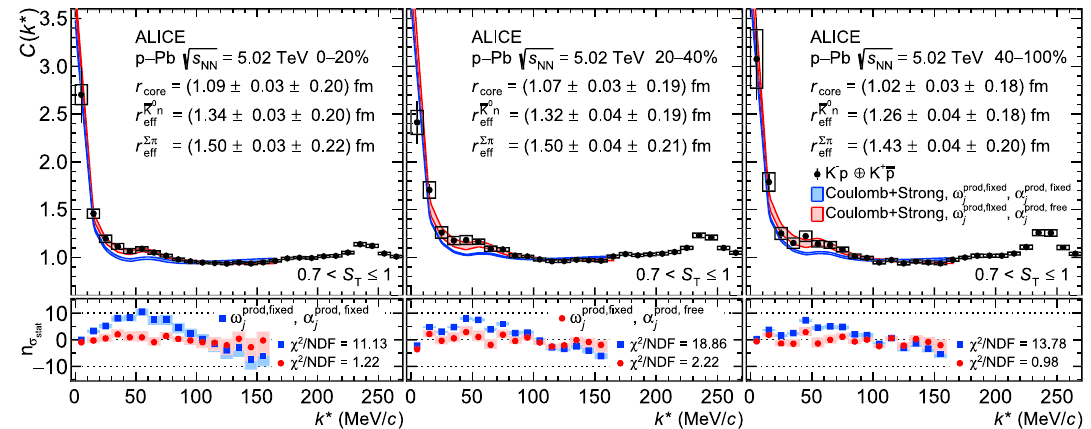
Fig. 5 (K − p ⊕ K + p) correlation functions obtained in p–Pb collisions √ s NN = 5 . 02 TeV in the 0–20% (left), 20–40% (middle) and 40– at 100% (right) centrality intervals. The measurement is shown by the black markers, the vertical error bars and the boxes represent the statis- tical and systematic uncertainties, respectively. The red and blue bands